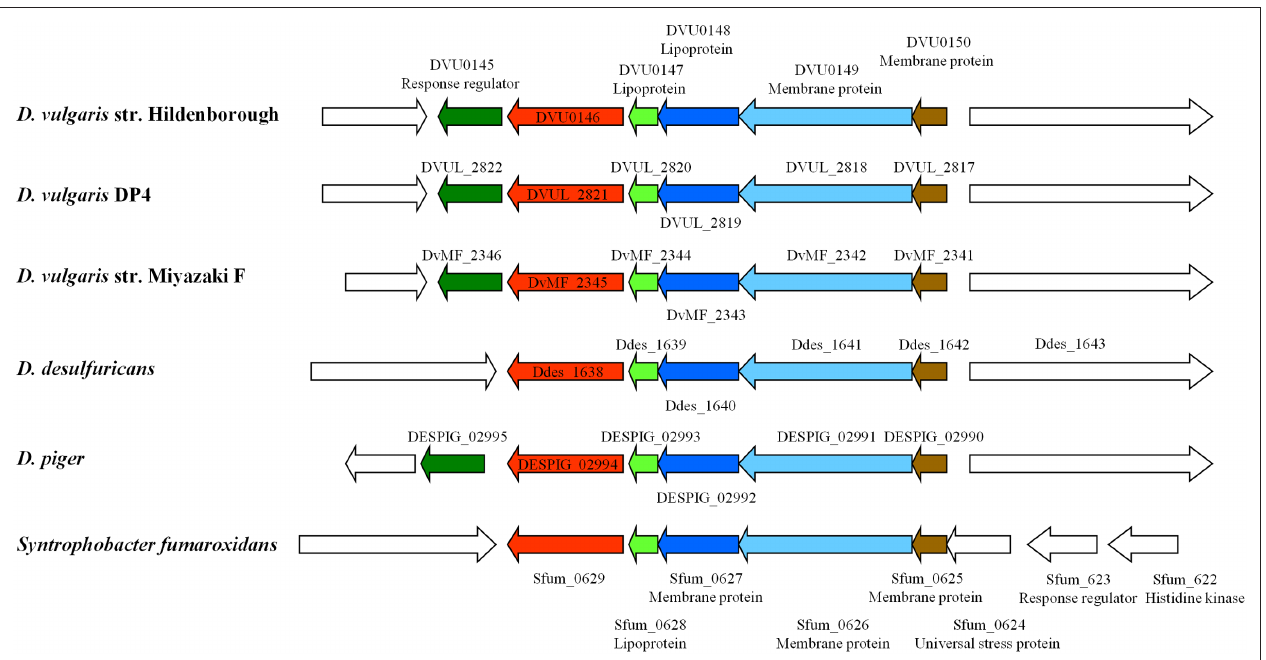
Figure 1 | A gene cluster with orthologs only in Syntrophobacter fumaroxidans and four recently sequences Desulfovibrio strains was significantly down-regulated during shift from syntrophic to sulfidogenic metabolism (Printed from Plugge et al., 2010, with permission of